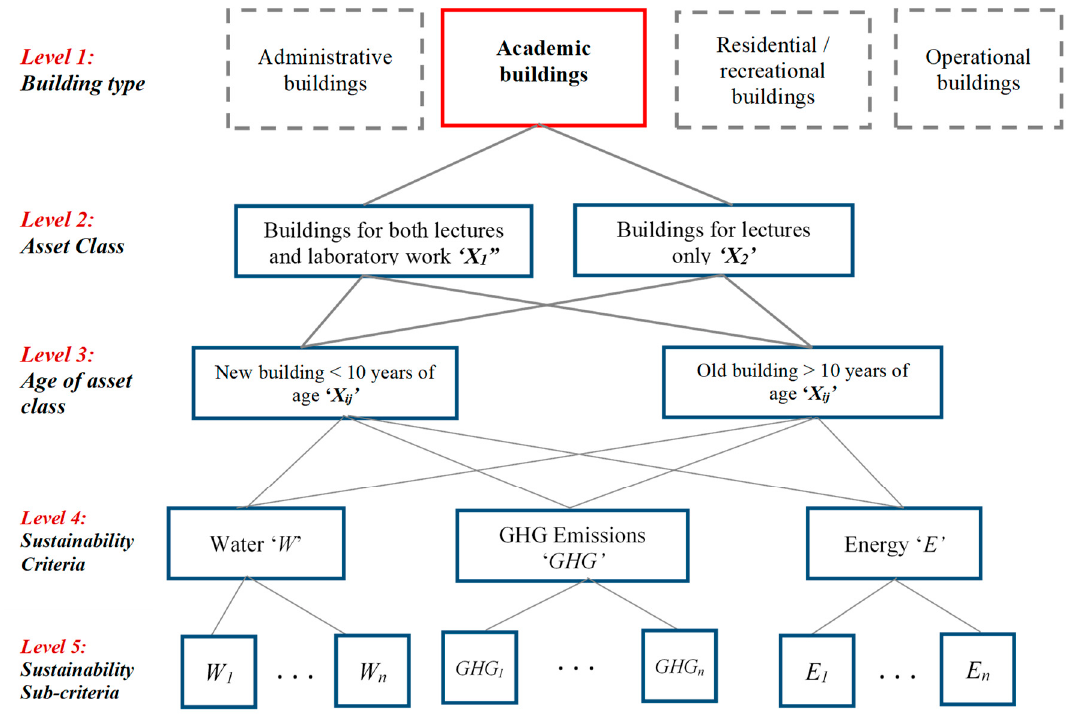
Figure 3. AHP hierarchy structure.